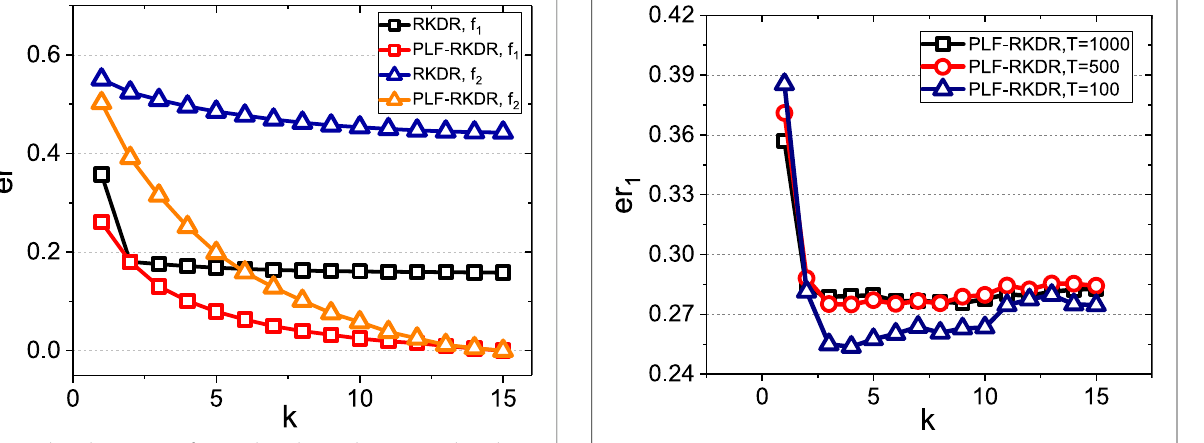
Fig. 2 The impact of k on the absolute error of PLF-RKDR algorithm on the simulation dataset